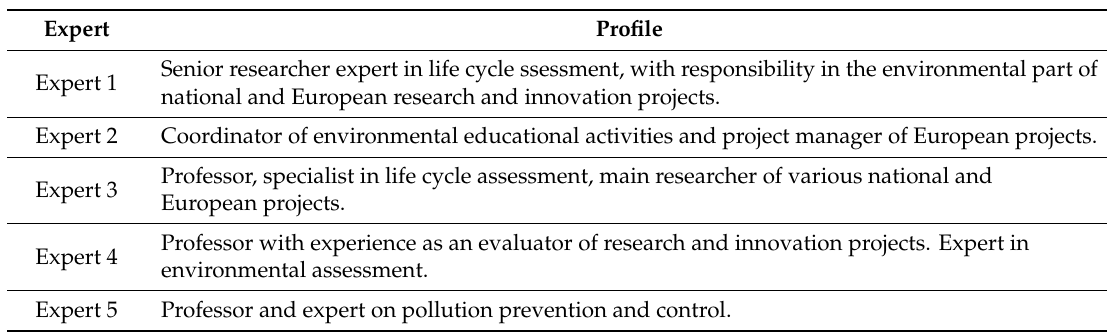
Table 1. Experts’